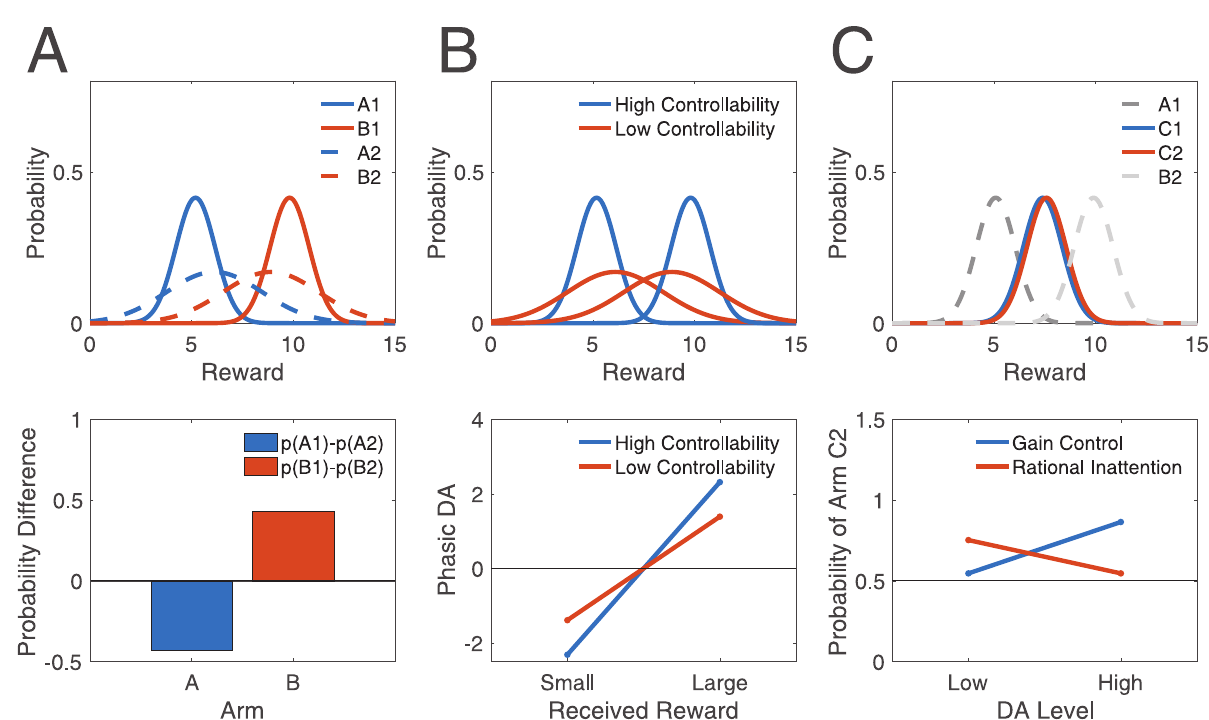
Fig 8. Experimental predictions of rational inattention. (A) Top panel: The difference in value estimates for two arms is higher under high controllability (solid curves) than low controllability (dashed curves). Bottom panel: After learning under each condition, the two arms yielding small rewards are compared. Rational inattention predicts that the arm trained under low controllability will be selected more often. On the other hand, when the two arms yielding large rewards are compared, that trained under high controllability will be selected more often. p(A1): probability of selecting arm A1; similarly for B1, A2, and B2. (B) Top panel: When a single arm yields a small or large reward with equal probability, the estimated deviation of actual outcomes from the mean reward will have larger magnitude under high-controllability learning than under low-controllability learning. Bottom panel: Thus the small reward will elicit a more negative phasic DA response, and the large reward will elicit a more positive phasic DA response, under high controllability than under low controllability. (C) Top panel: Arms C1 and C2 are identical, but C1 is trained with an arm yielding a smaller reward (A1), and C2 is trained with an arm yielding a larger reward (B2). The estimates for the two identical arms will be on opposite sides of their true value due to the central tendency. Bottom panel: After training, arms C1 and C2 are combined into a new two-armed bandit task, occurring under either high or low DA. The gain control hypothesis of DA predicts that the difference in their estimates will be amplified under high DA, thus making selection of C2 more likely than under low DA. On the other hand, rational inattention predicts that the central tendency will be reduced under high DA, which, in this task, will cause the two estimates to migrate closer to their true reward value (and therefore, to each other), in turn making selection of C2 less likely than under low DA. See Methods for simulation details.